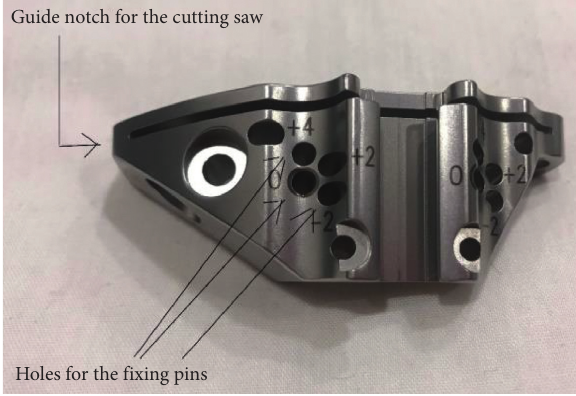
Figure 1: Tibial cutting blocks for left knees. Table 1: Tibial component alignment in three